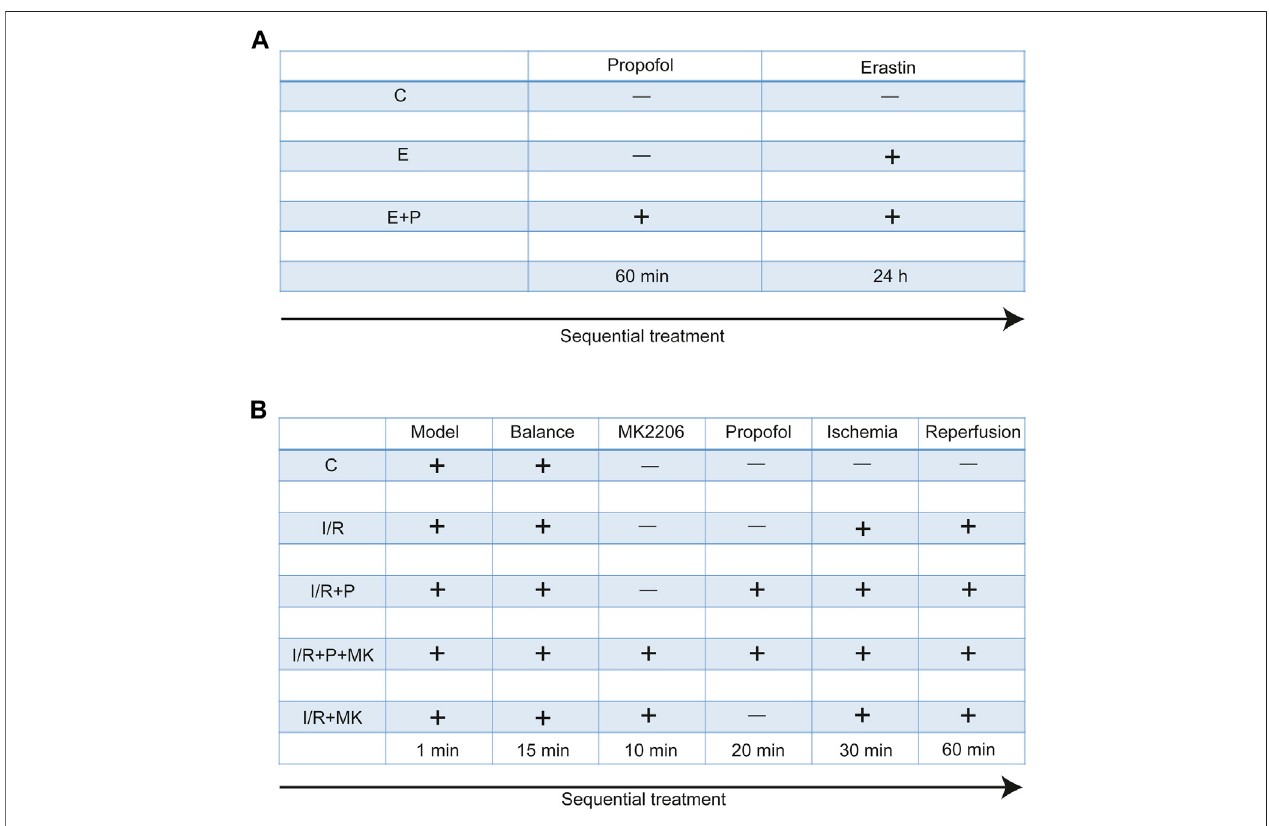
FIGURE 1 | Experimental grouping and corresponding treatment. Experimental grouping and corresponding treatment on H9C2 cells (A) and rat hearts (B) .